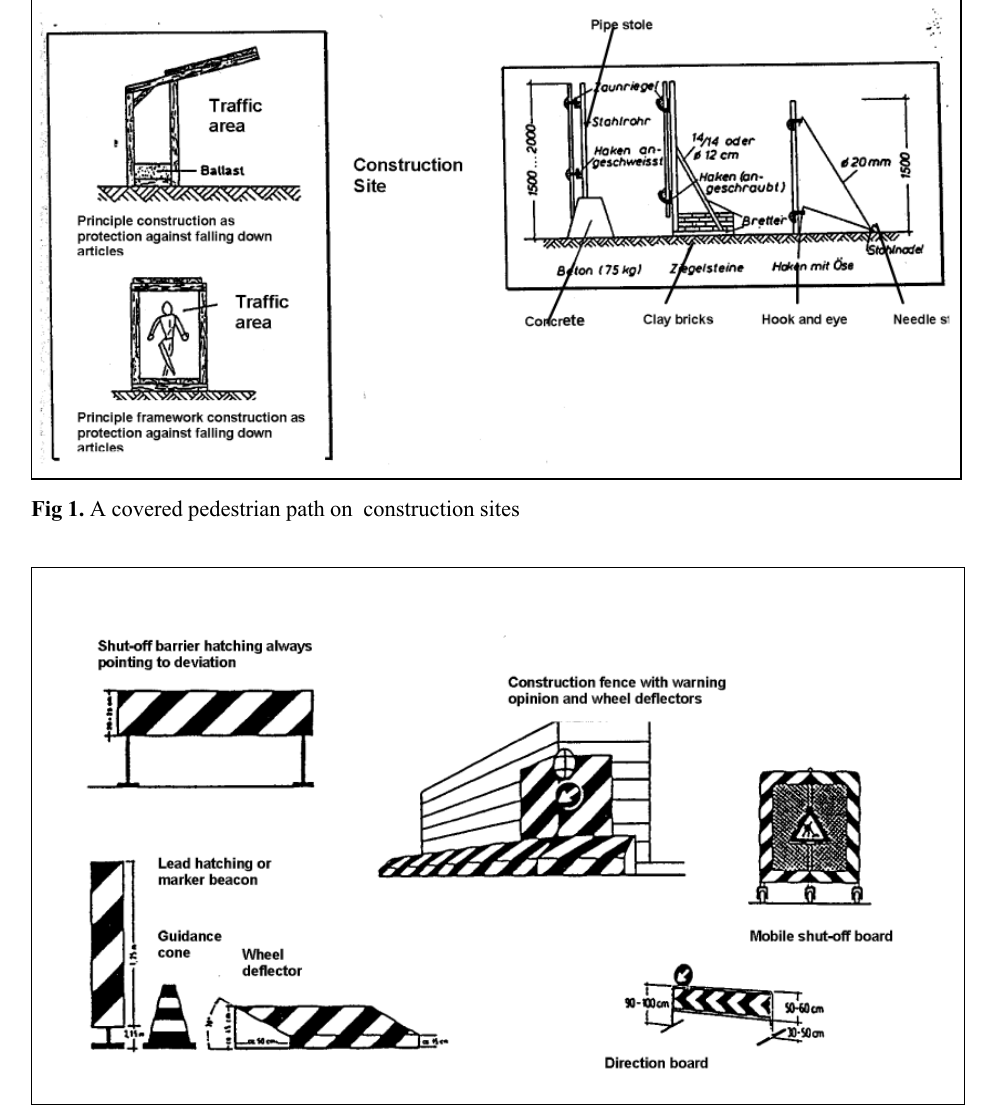
Fig 2. Building site traffic management